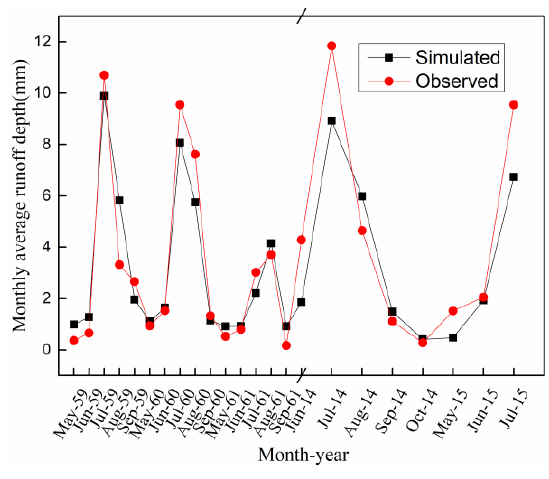
Figure 8. Comparison of observed and simulated monthly runoff depth. Table 3. Descriptions and optimized parameter sets of HBV for the LHGB.